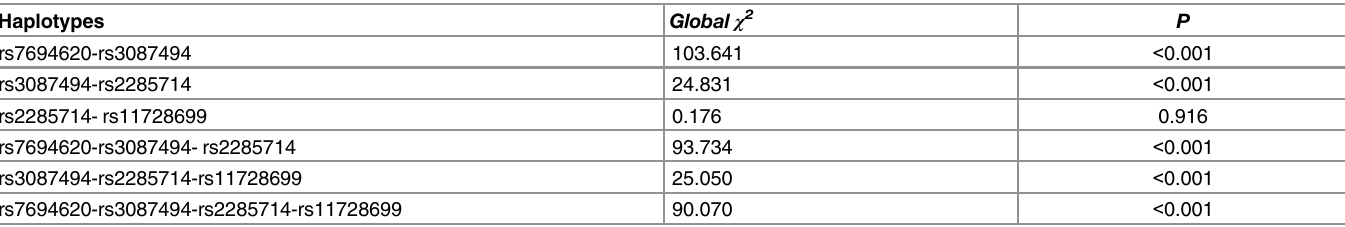
Table 4. The association between PLA2G12A haplotypes and schizophrenia.